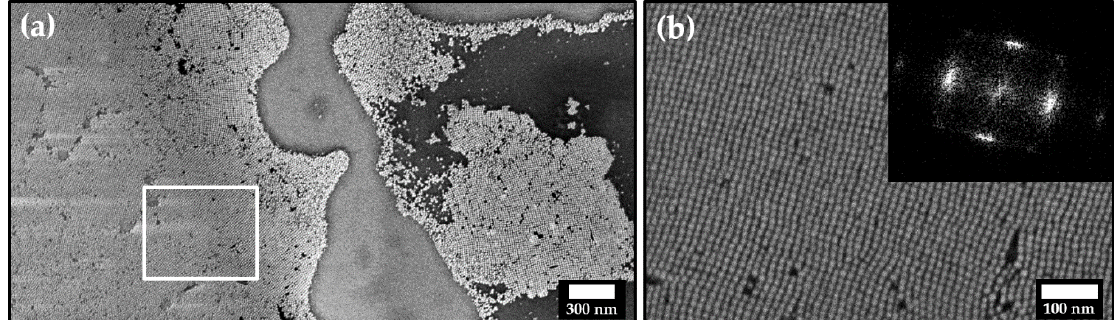
Figure 2. ( a ) Field emission scanning electron microscope (FESEM) image of self-assembled platinum nanocube monolayers. At higher magnification ( b ), single particles can be resolved, revealing typical crystallographic defects such as vacancies and dislocations. The inset shows the FFT pattern of image ( b ).